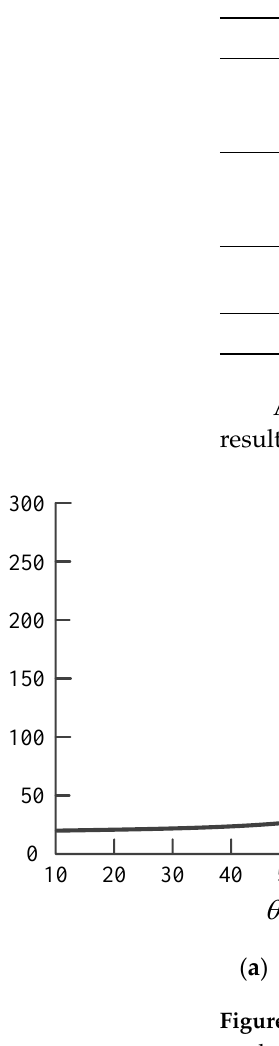
Table 3. Simulation experiment parameters in [20].